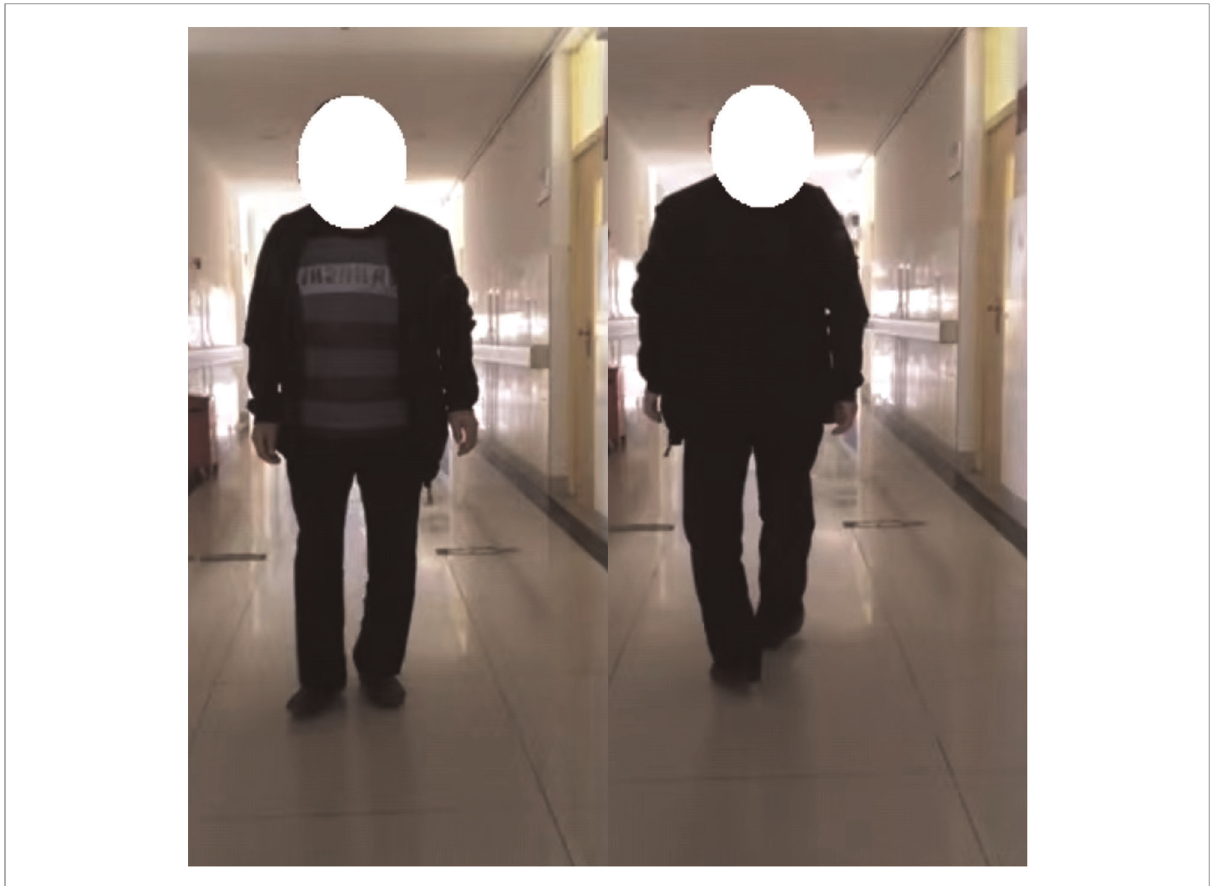
FIGURE 2 Pre-operative standing and walking status of the patient. (Figure notes: The patient had bilateral hip inversion and showed a cross gait when